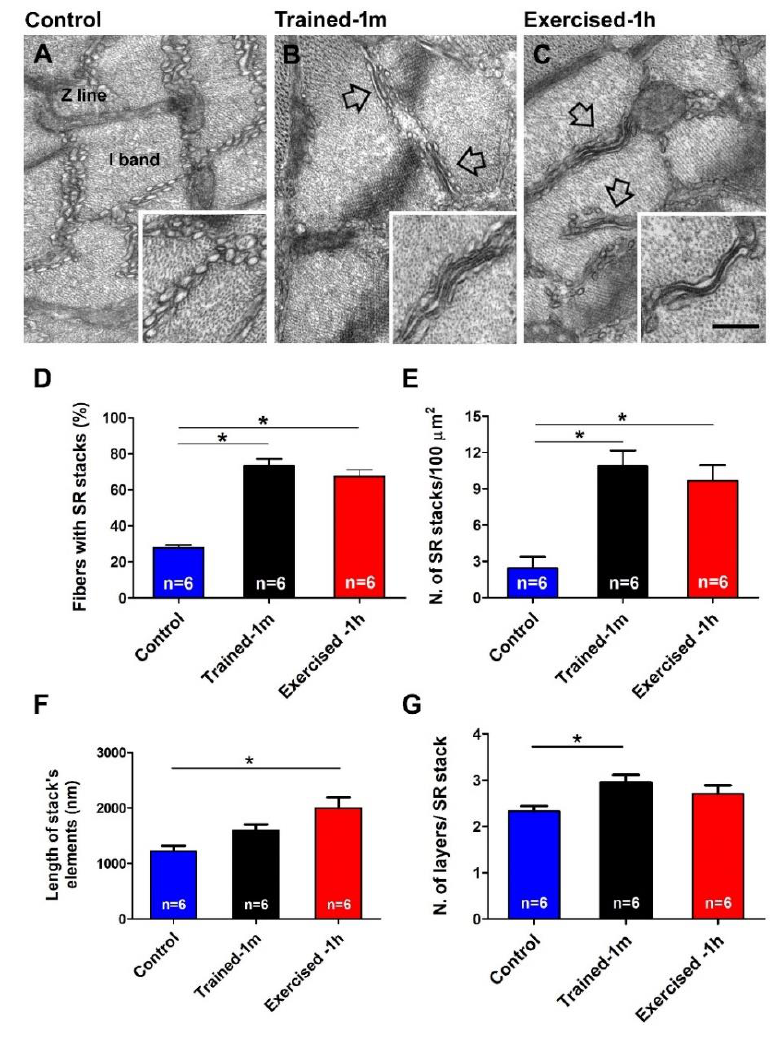
Figure 3. Electron-micrographs and quantitative analysis of SR-stacks: ( A – C ) EM images of EDL fibers show the typical organization of the SR at the I band from control ( A ), trained-1 m ( B ) and exercised-1 h ( C ) mice. The inset in ( A ) shows SR vesicles; the arrows and the insets in ( B , C ) show the remodeling of SR to form stacks in samples from mice trained-1 m and exercised-1 h. ( D , E ) Percentage of fibers containing SR-stacks and number of SR-stacks/100 µ m 2 of section. ( F , G ) Length of stack’s elements (nm) and number of layers/SR-stack. Data are shown as mean ± SEM (* p < 0.05; the two ends of the line with asterisk indicate which two groups are being compared). Note, n = number of EDL analyzed. Scale bar: ( A – C ) = 0.1 µ m; insets = 0.2 µ m. See also Supplementary Figure S4 for quantitative analysis of SR-stacks after the ES